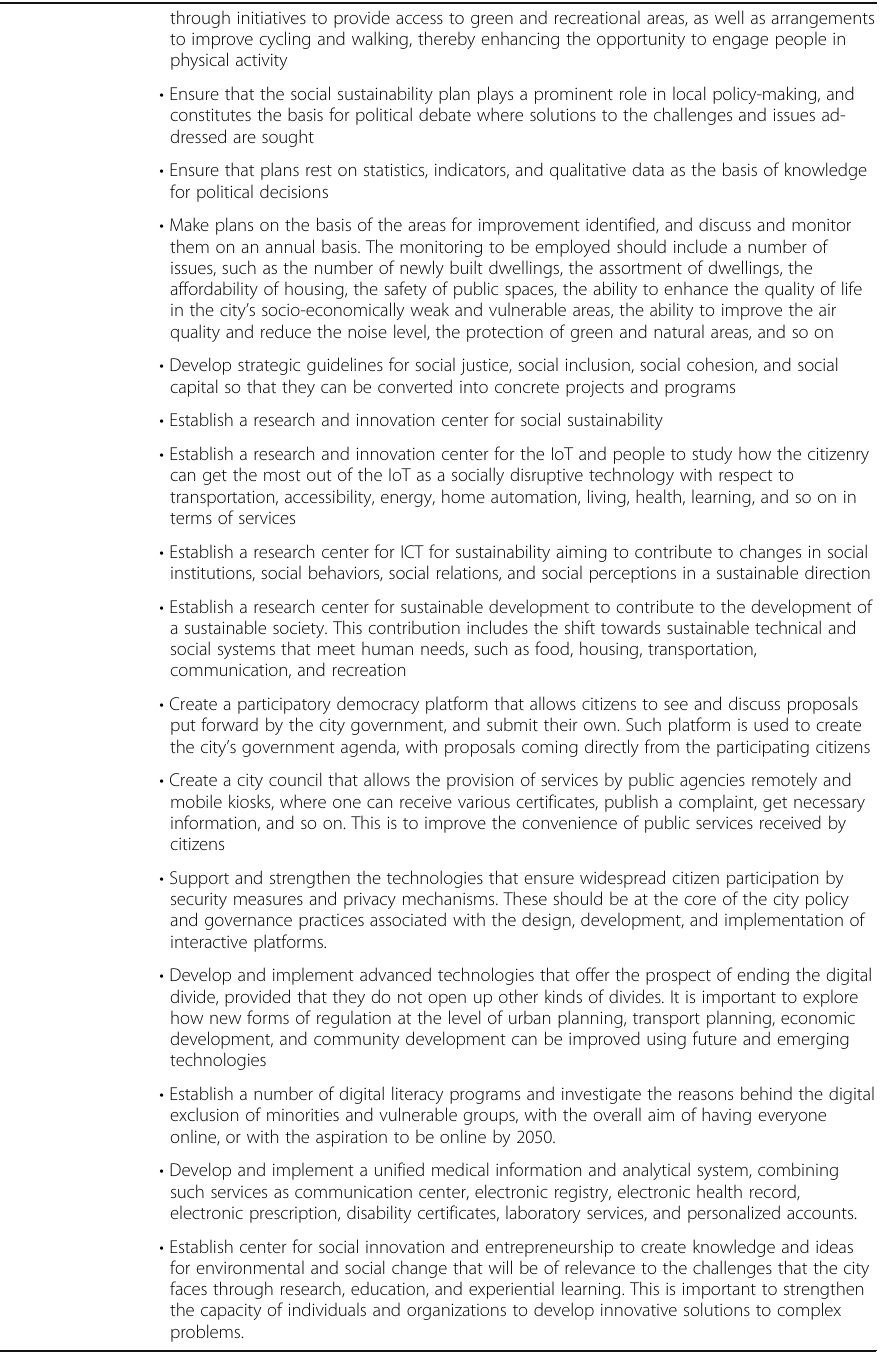
Table 7 The core institutional practices for supporting the balancing of the three dimensions of sustainability